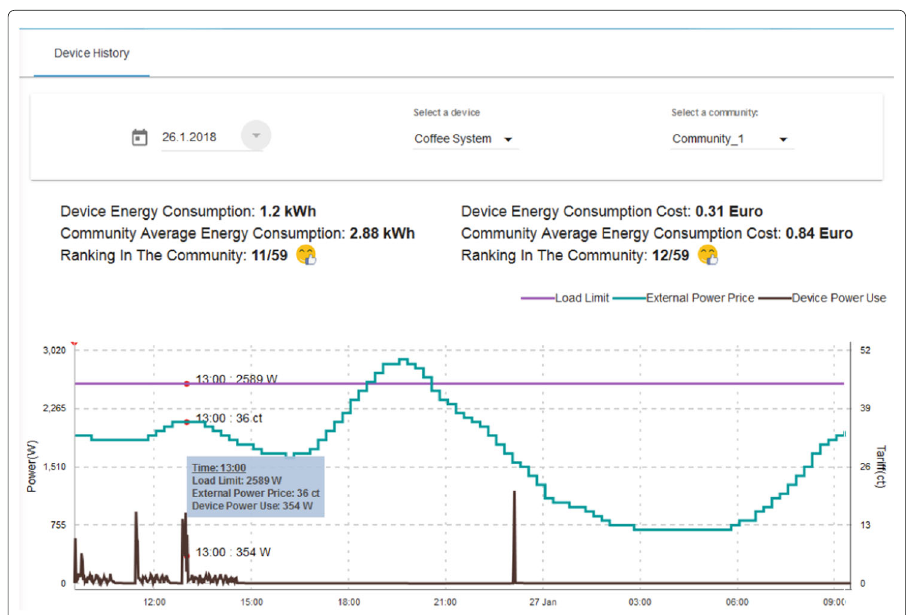
Fig. 22 BOS UI: the historical energy use of a single